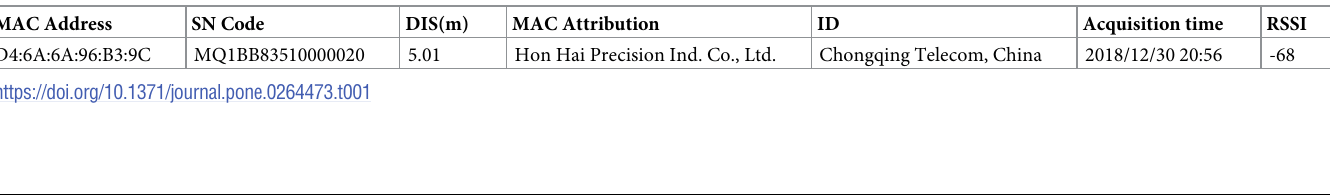
Table 1. Data format of the Wi-Fi probe acquisition